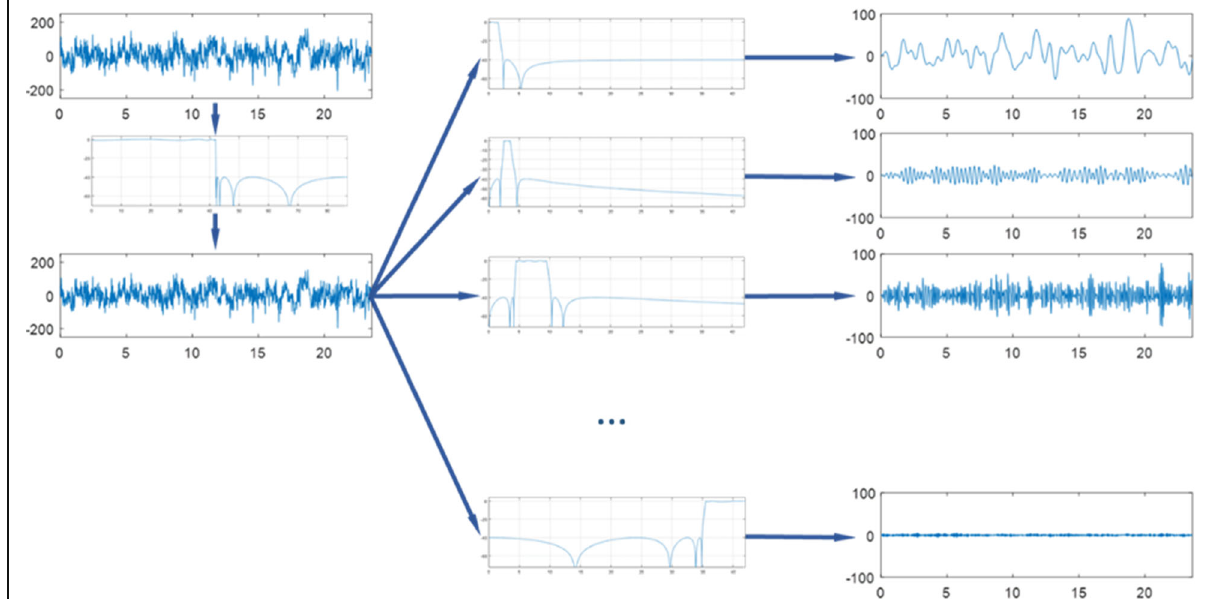
Fig. 4 Spectral feature extraction step. After initial filtering (0 – 42 Hz), the signal is filtered with N + 1 elliptic filters (middle column), resulting to N + 1 filtered signals (right